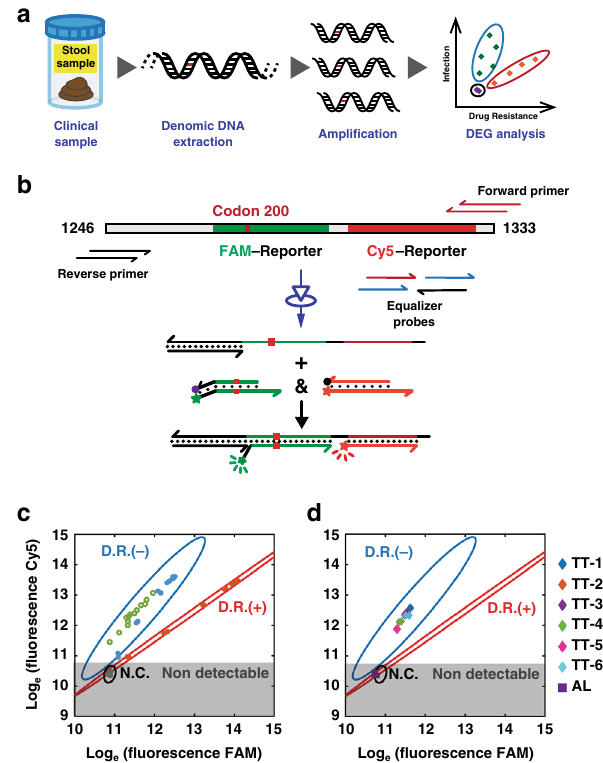
Fig. 7 Application of DEG-PCR to analyzing clinical parasitic worm samples. a A typical work fl ow for analyzing parasitic worm ( Trichuris trichiura , TT) specimens collected from stool samples of school-age children in the rural areas of Honduras followed by the detection using DEG-PCR. b Simultaneous detection of parasitic infection and screening for drug-resistance was achieved using a dual-channel design (FAM- and Cy5- Reporter). PCR primers were designed to amplify nucleotide 1246-1333 in the β -tubulin gene, containing the 200 th codon. A single nucleotide A to T mutation of this codon is a hotspot for drug resistance screening. A toehold-exchange reporter (FAM-reporter, green duplex) labeled with FAM was used to discriminate this point mutation, whereas a strand- displacement reporter with no reverse toehold (Cy5-reporter, red duplex) was employed to detect a conservative region near codon 200. Experimental tests of the dual-channel DEG-PCR using synthetic DNA standards (blue and red dots) and 13 (D.R. ‒ ) clinical samples (green circles) as a training set ( c ) and 8 unknown clinical parasitic worm samples ( d ). Test results are classi fi ed into three areas de fi ning the positive infection and drug resistance (D.R. + ), positive infection and no drug resistance (D.R. ‒ ), and negative infection (N.C.). Error eclipses with 99% con fi dence interval and 2-degrees of freedom (two fl uorescence channels) were used to de fi ne D.R. + and D.R. ‒ . Eight clinical worm specimens including six Trichuris trichiura worms (TT-1 to TT-6) and two A. lumbricoides worms (AL, as negative controls) were tested and plotted in ( d ). Source data are available in the Source Data fi le.